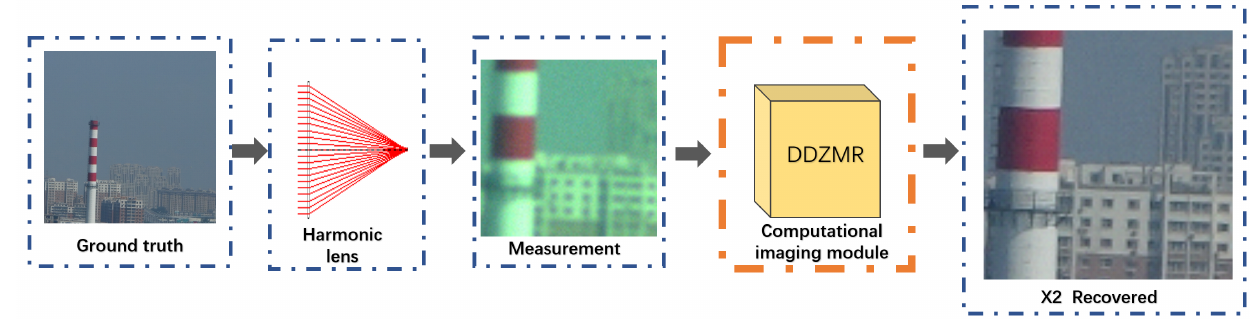
Figure 1. Schematic diagram of SHCIS: degraded low-resolution images are measured by single- lens HDOE and color RGB detectors.The DDZMR network performs image restoration and image super-resolution on degraded images to generate high-quality